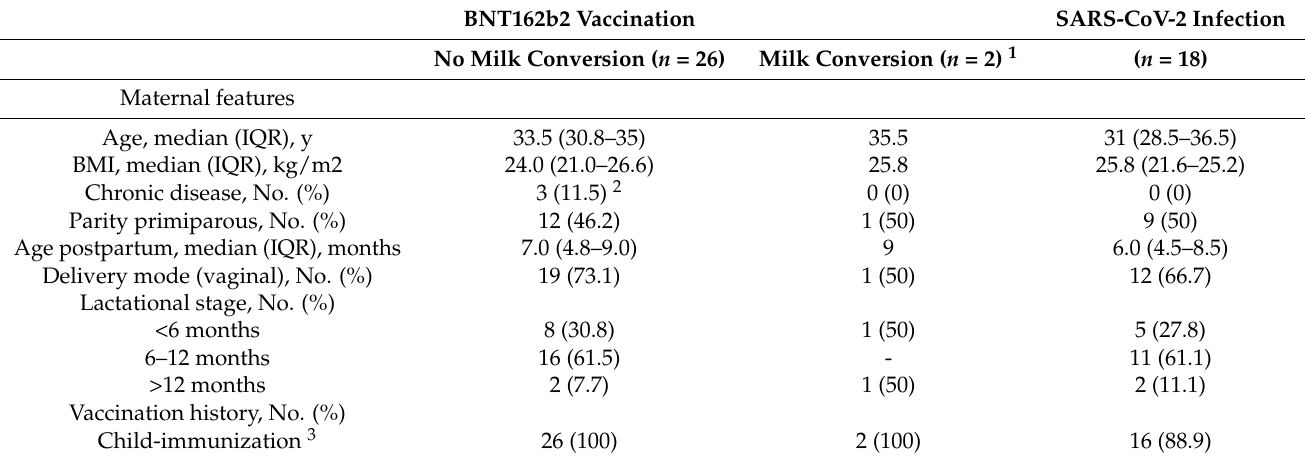
Table 1. Characteristics of participants at first